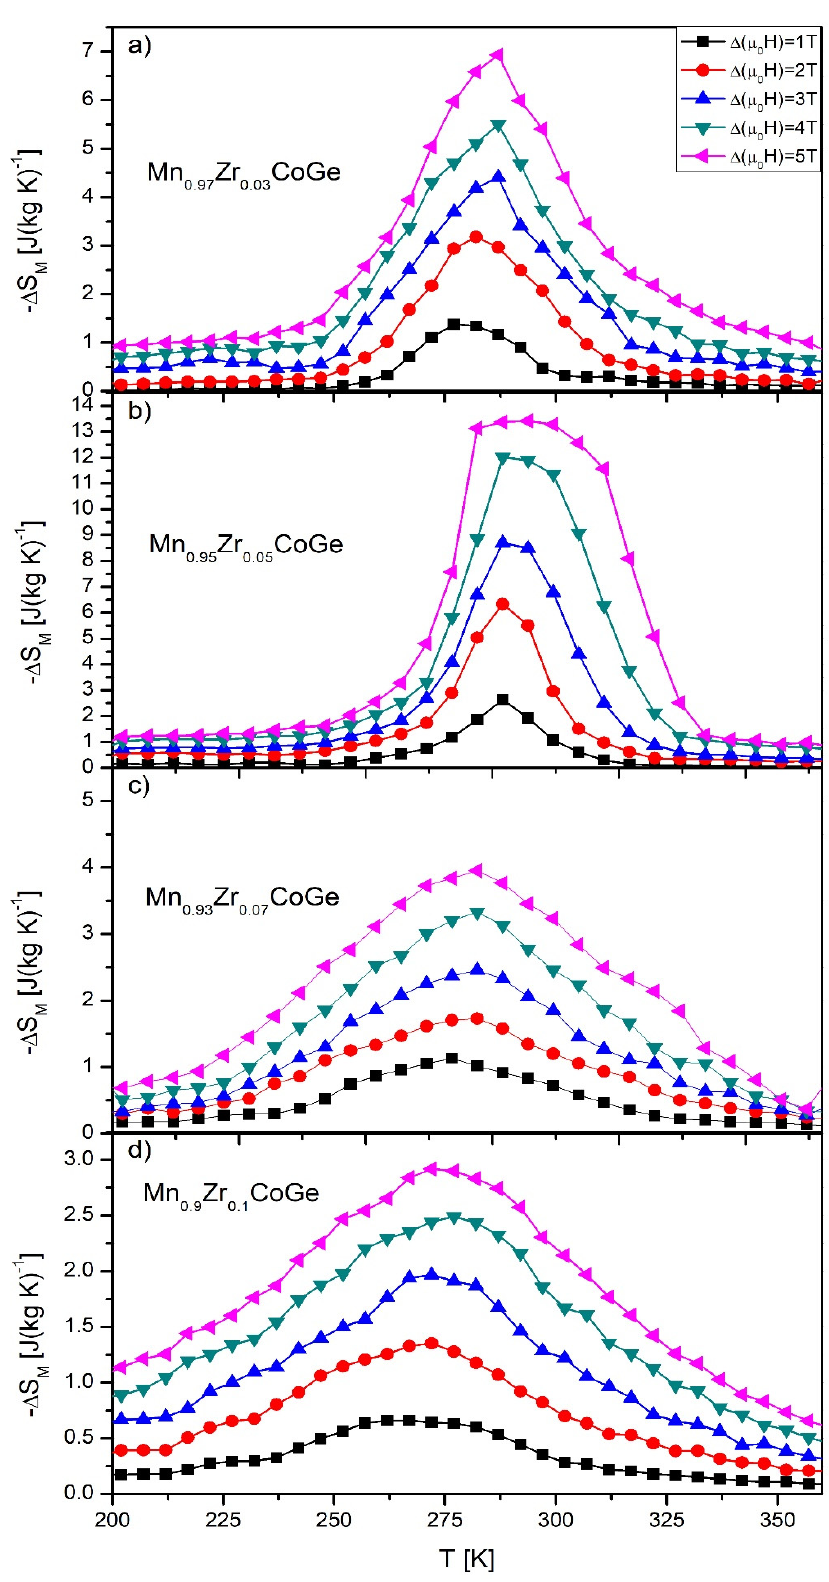
Figure 6. The temperature dependences of the magnetic entropy changes calculated for Mn 0.97 Zr 0.03 CoGe ( a ), Mn 0.95 Zr 0.05 CoGe ( b ), Mn 0.93 Zr 0.07 CoGe ( c ), and Mn 0.9 Zr 0.1 CoGe ( d ) alloys.